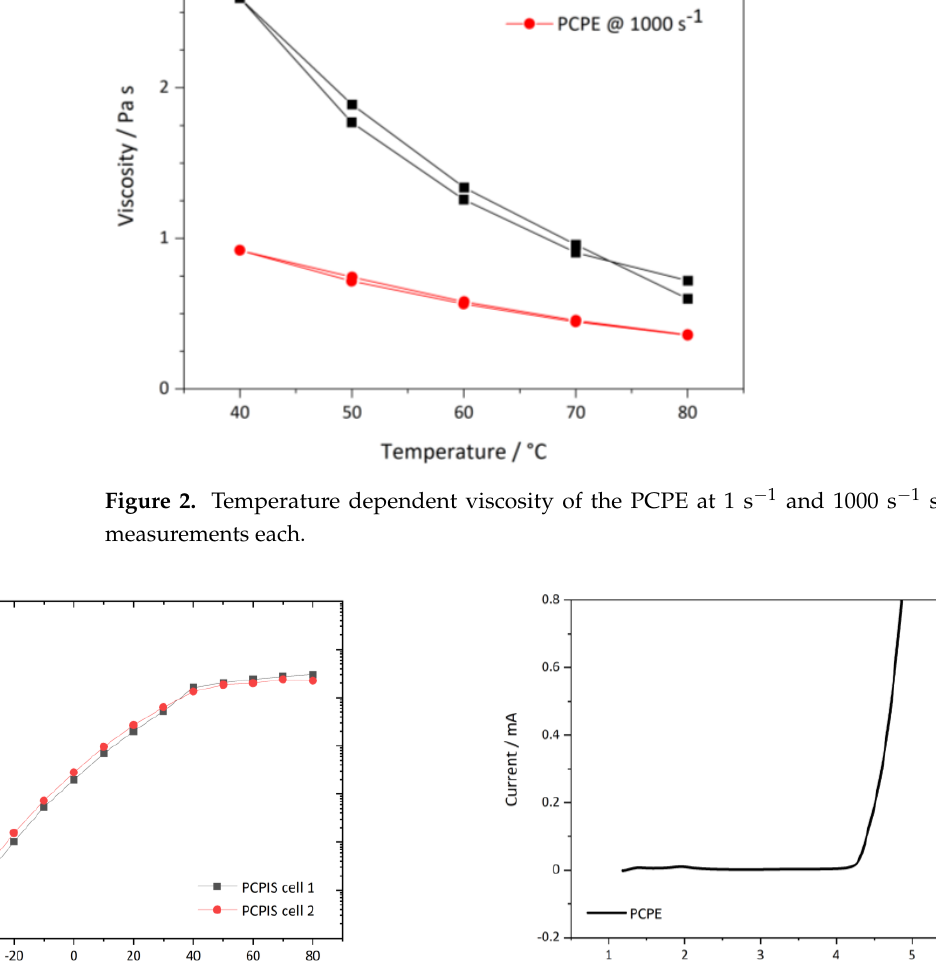
Figure 2. Temperature dependent viscosity of the PCPE at 1 s −1 and 1000 s −1 sheer rate; two meas- urements each.